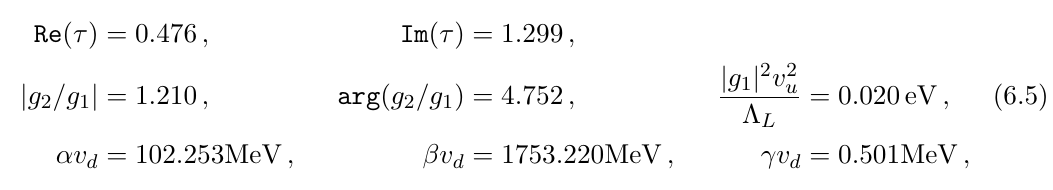
Table 4 . Values of neutrino masses and mixing parameters at the best (cid:12)t point, eq. (6.5), obtained from the latest global (cid:12)t of NuFIT v4.1 [39, 40]. the complex combination g =g and the (cid:28) VEV. An excellent (cid:12)t [38] to neutrino masses 2 1 and mixing angles is obtained by the choice: